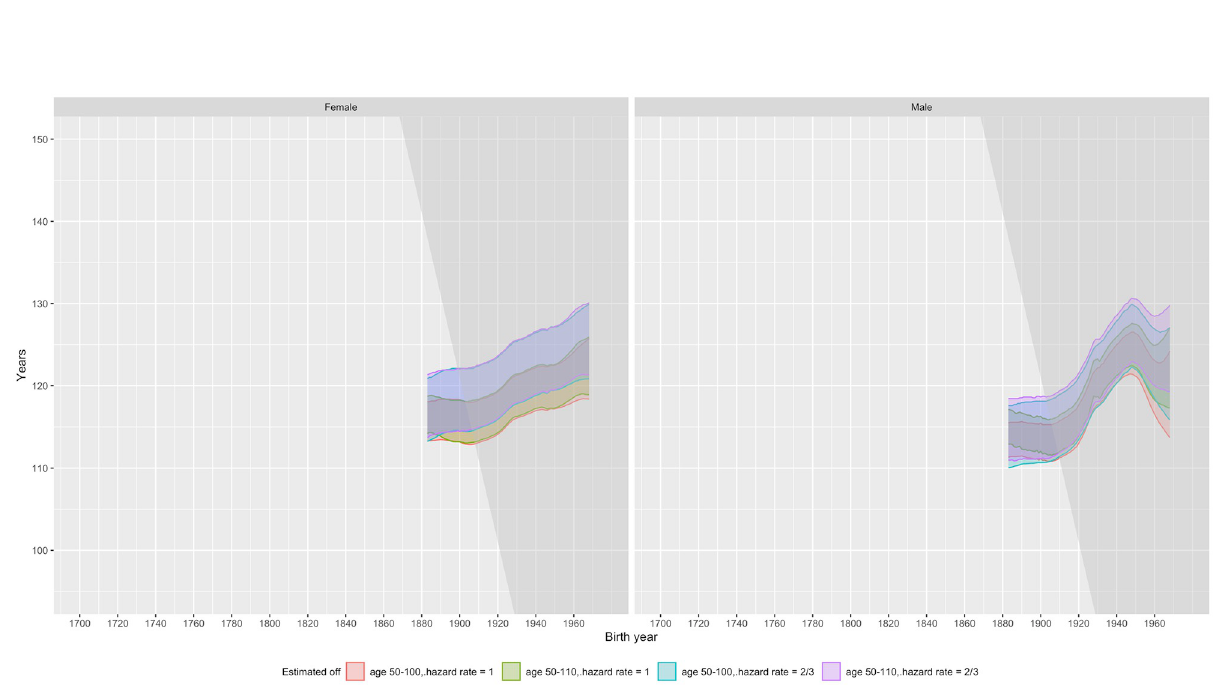
Fig 9. Confidence intervals for M for the USA using combinations of use of data ages and assumption of the height of the plateau. c